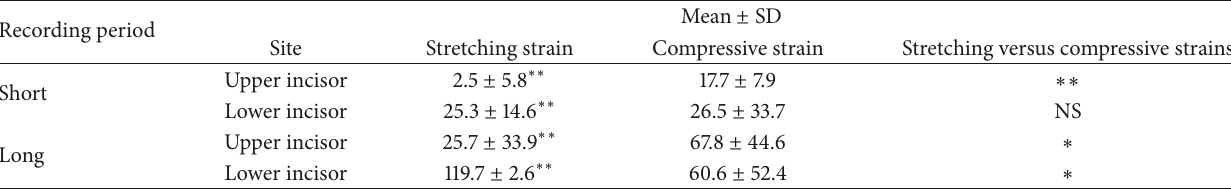
Table 1: Comparison of the strain on the incisors.